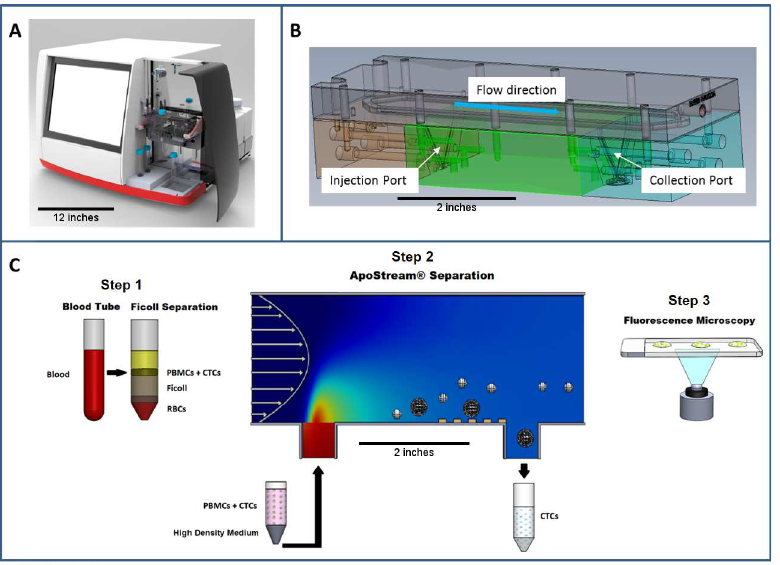
Fig 1. Schematic representations of the ApoStream ® device. (A) ApoStream ® prototype instrument. The device has a width of 24 inches, and a heightof 17 inches. The scale bar represents 12 inches. (B) 3D CAD model of the flow chambershowingV-shapedinjectionand collectionports. The chambermeasures6 inches (length), by 2 inches (height), by 2 inches (depth). The scale bar represents 2 inches. (C) Step 1: Sample processingby Ficoll density gradientseparation to isolate PBMCs and CTCs. Step2: DEP enrichment starting with sample injection, ion diffusion, DEP separationof CTCs from PBMCs, and CTC collection.The scale bar represents 2 inches. Step 3: downstreamanalysisusing immunofluorescenceor other techniques for CTC identification and enumeration.